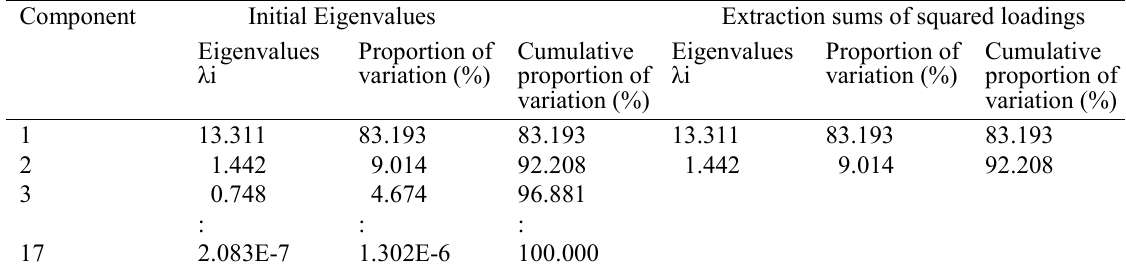
Table 1 Principal component analysis of the seventeen socioeconomic activity indicators.